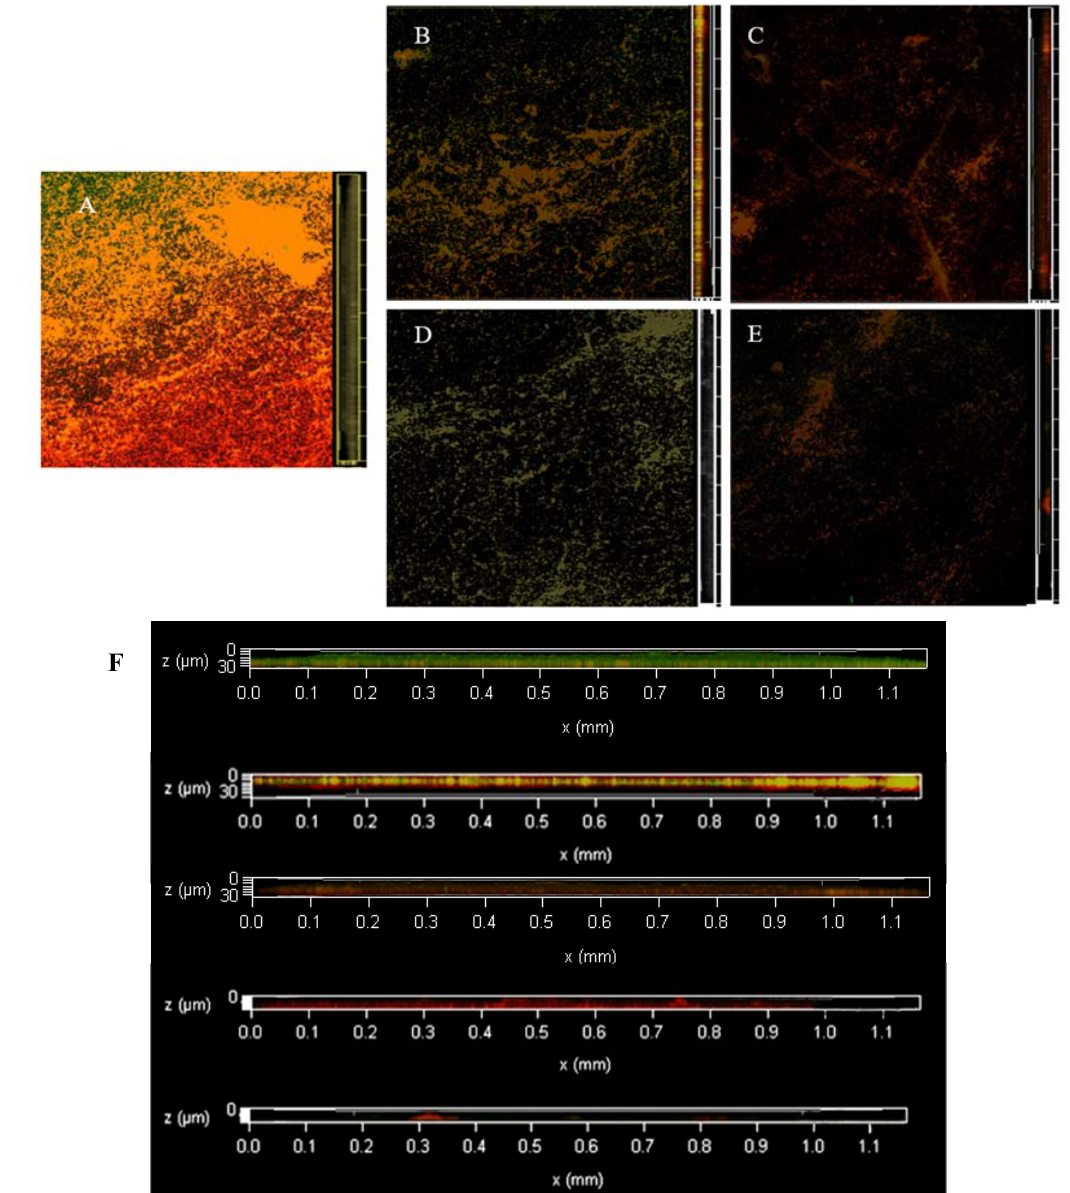
Figure 12. The changes of eDNA and eRNA in LM biofilm after AEW and ALEW treatment observed by CLSM; each sample randomly selects three visual fields. Images include front and side views of the biofilm under CLSM. Scale bar—100 µ m. ( A ) is control, ( B ) is S 3 A 1 S 1 treatment, ( C ) is A 1 S 4 treatment, ( D ) is S 6 A 2 S 2 treatment, and ( E ) is A 2 S 8 treatment. ( F ) is an enlarged version of all the images on the right and is also a right-hand view of the biofilm, from top to bottom, for AEW and NEHW treatments 0, 2, 4, 6, 8 and 10 min respectively. AEW was acidic electrolytic water, and ALEW was alkaline electrolysed water.